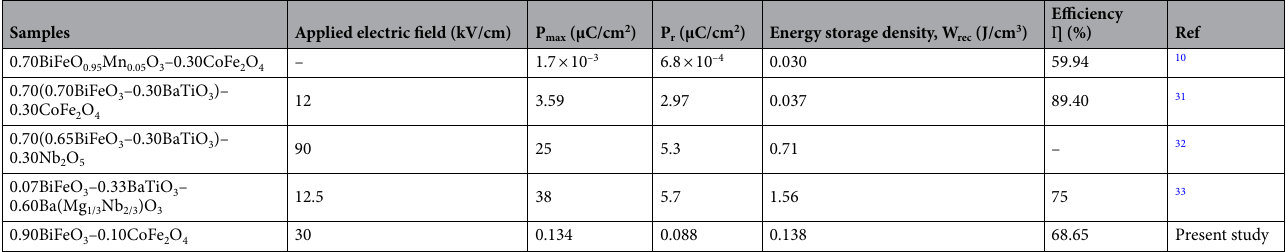
Table 3. Comparison of ferroelectric and energy storage properties of recently reported BFO based ceramics samples.